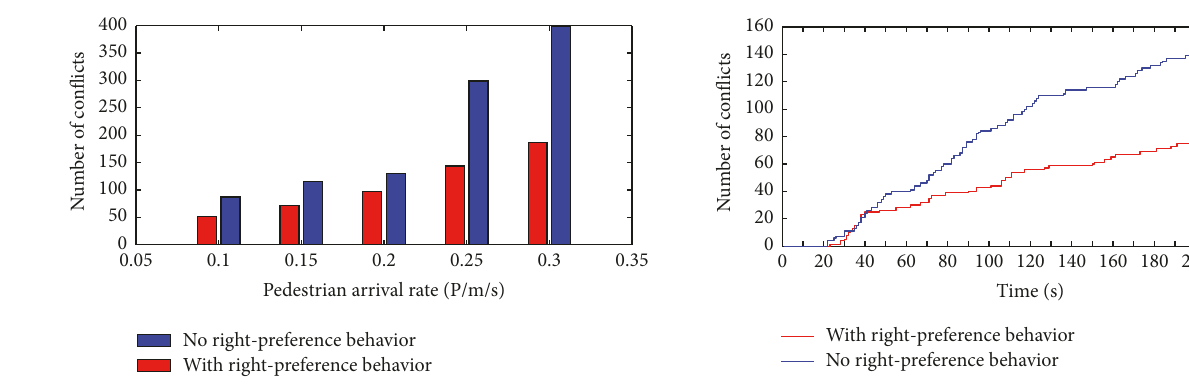
Figure 17: The plot of the number of conflicts versus the time. In the simulation, the pedestrian arrival rate is 0.2 P/(m ⋅ s), 𝜙 = 1 and 𝜆 = 0.2 m. | < 𝑟 + 𝑟 𝑖𝑗 𝑖 𝑗 .